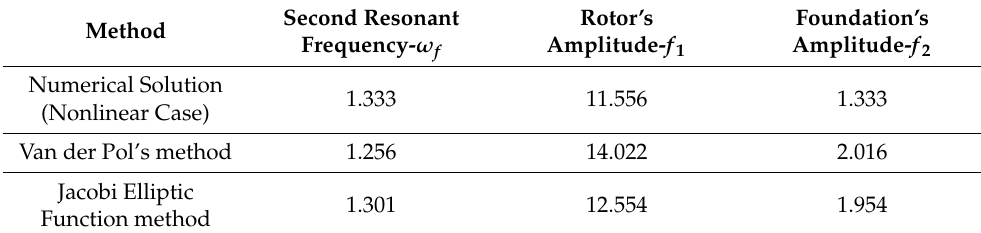
Table 2. Amplitude values at the second resonance for different